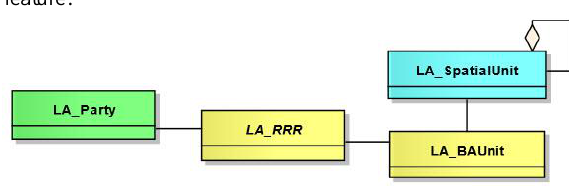
Figure 2. Basic packages of LADM